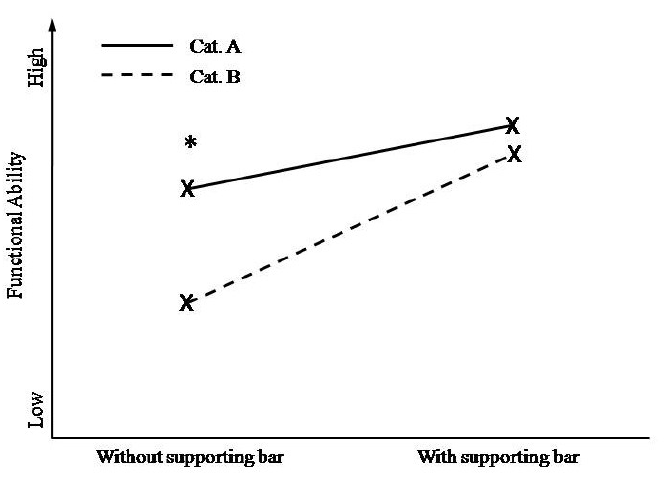
Functional ability between Category A and B participants with and without using the supporting bar. The functional ability in the y-axis is the mean standardized score of all trunk functional ability indices. * p